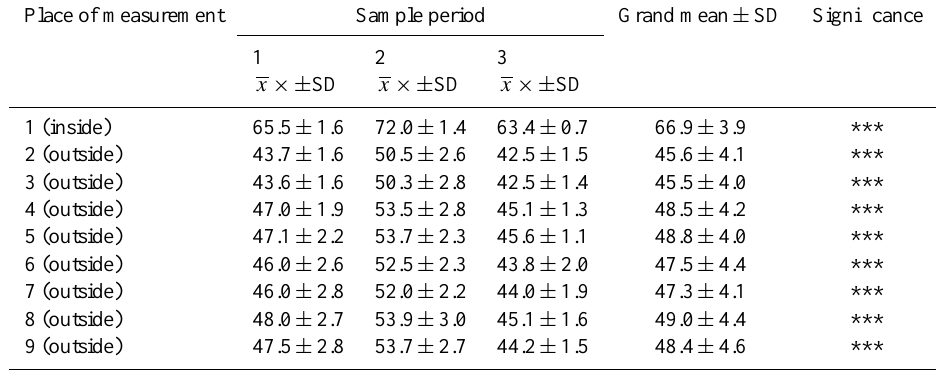
Table 1. Effect of time of day on noise levels. The sample size, N , was 30. Place of measurement Sample period Grand mean ± SD